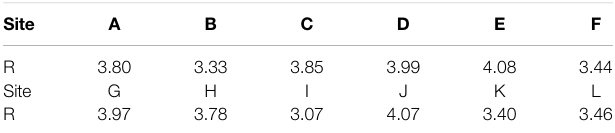
TABLE2| Resultsofroundnessfortheclastserodedfromtheinter fl uvesbetween the Taolai, Hongshuiba, and Fengle Rivers.